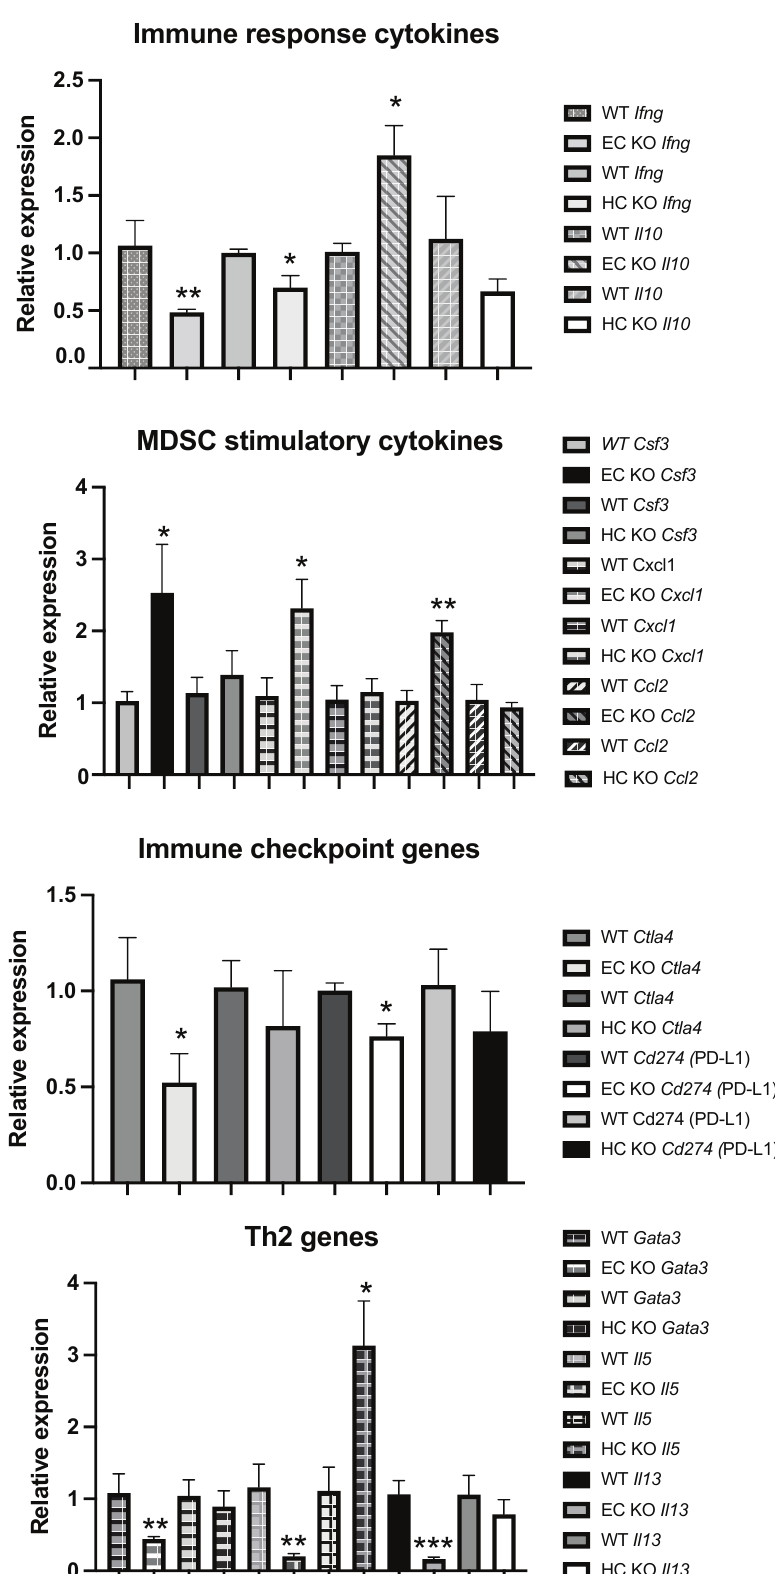
Figure 5. CD45 + cell gene expression of various genes related to immune cell function in tumors in mice from wild type (WT), EC Shb KO, and HC Shb KO mice. n = 4 for WT and n = 5 for EC KO. n = 3–9 for WT and n = 3–9 for HC KO. *, **, and *** indicate p < 0.05, p < 0.01, and p < 0.001, respectively, using a Student’s t